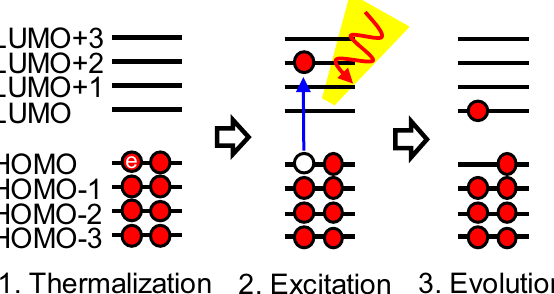
Figure 1. Sequence of TDDFT-MD modeling of reaction induced by electronic